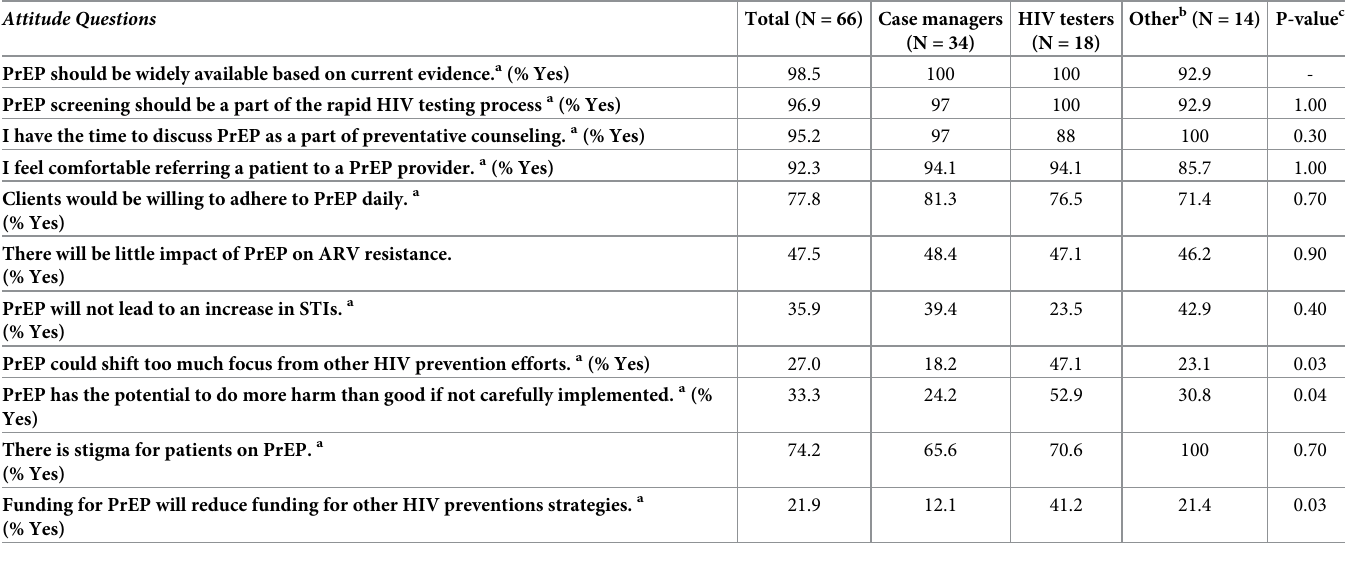
Table 3. Attitudes of non-prescribing providers in Philadelphia (N = 66). Attitude